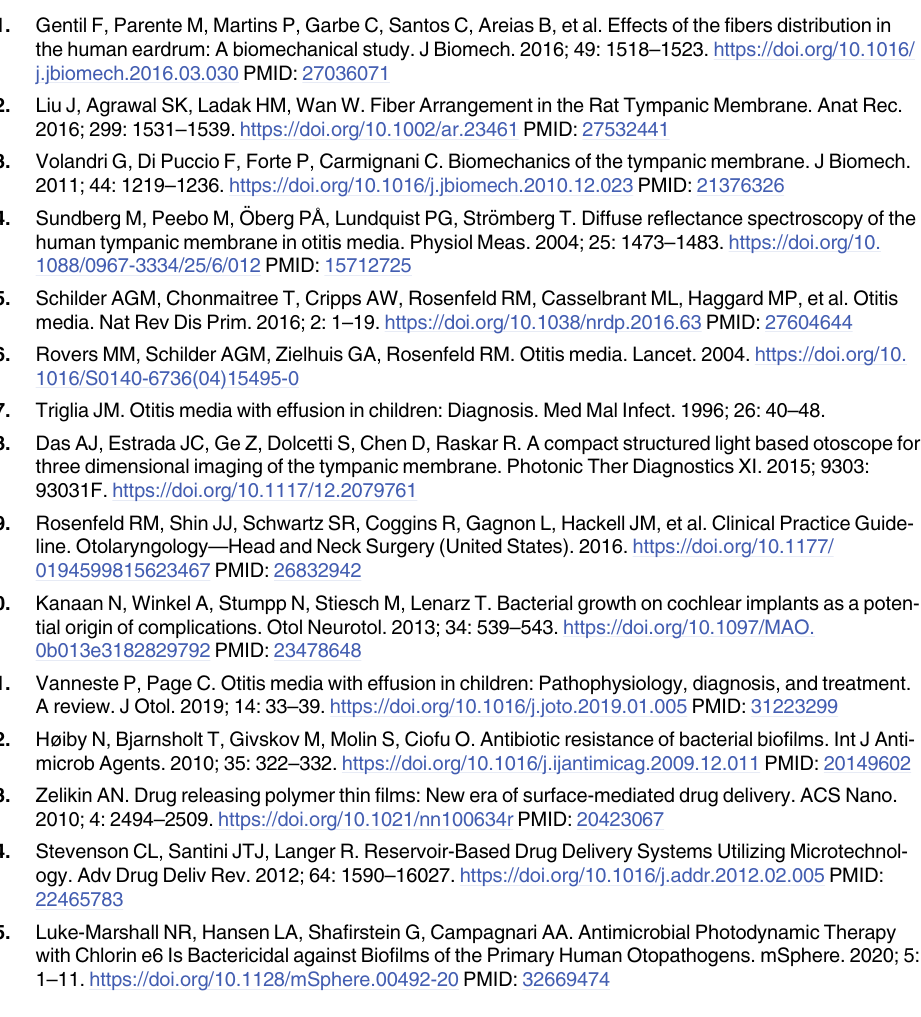
S2 Fig. Spectral scan of human sample 3. Scans were performed before (red) and after (blue) the area scan with about 1 hour in